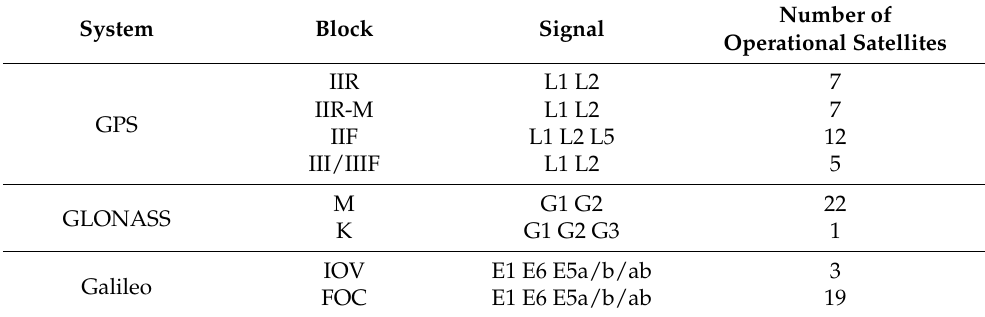
Table 1. Number of multi-GNSS satellites in orbit (until 2022)